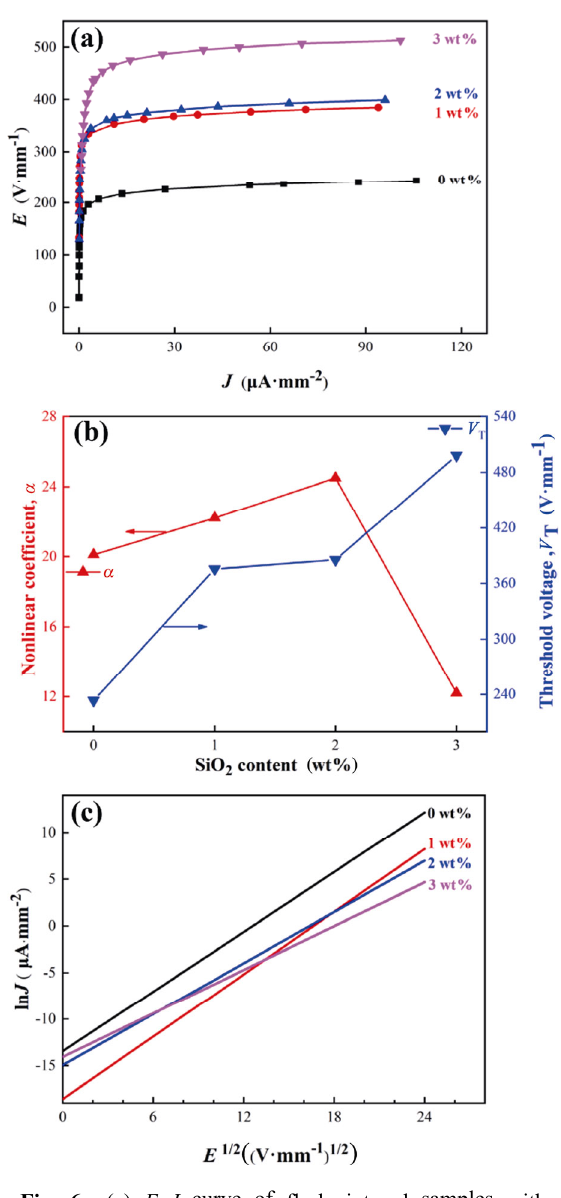
Fig. 6 (a) E – J curve of flash-sintered samples with different SiO 2 -doped content. (b) Variation of nonlinear coefficient and threshold voltage of the flash-sintered ZBM– x SiO 2 varistors ( x = 0–3 wt%). (c) ln J – E 1/2 curves of flash-sintered ZBM– x SiO 2 ( x = 0–3 wt%)